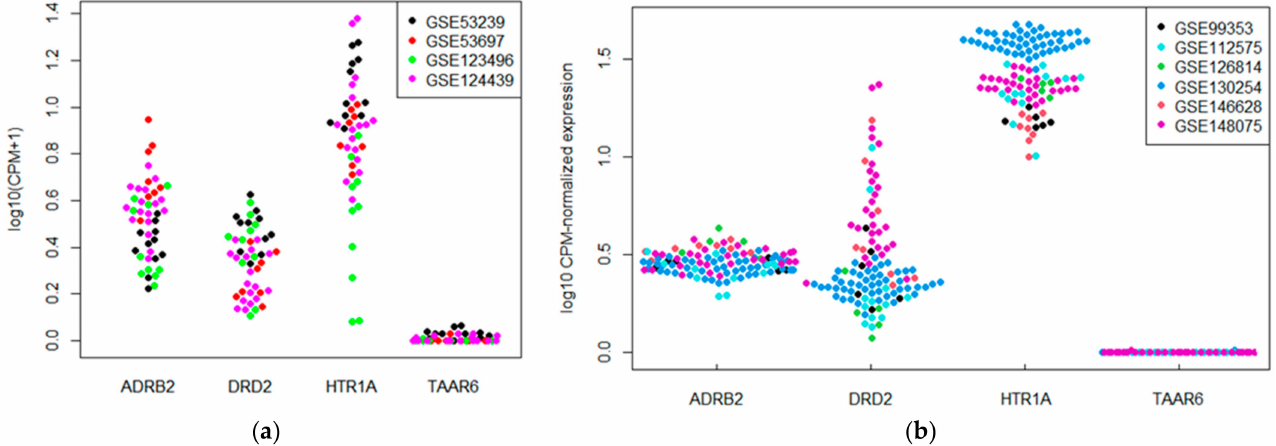
Figure 1. Expression levels of TAAR6, DRD2, ADRB2, and HTR1A in the neocortical tissues in ( a ) human and ( b )